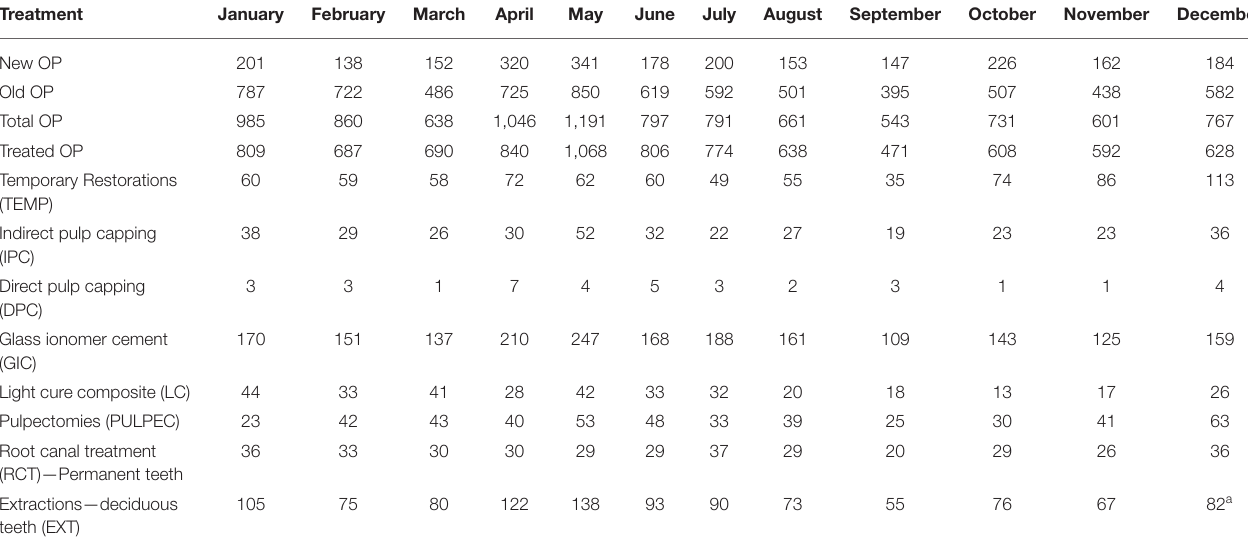
TABLE 1 | Average OP statistics of the Department of Pediatric and Preventive Dentistry, JSS Dental College and Hospital, Mysuru. Treatment